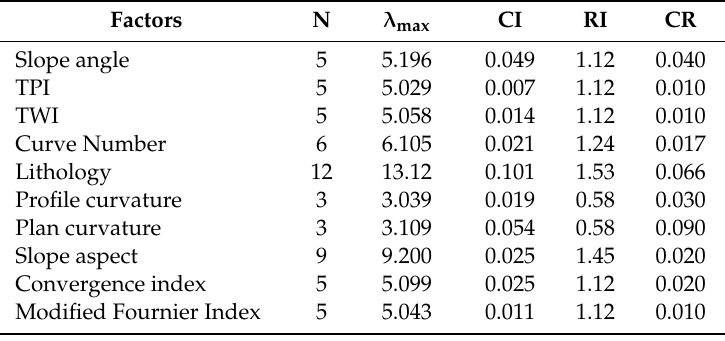
Table 1. Properties of comparison matrices in the Table S1 previous Table